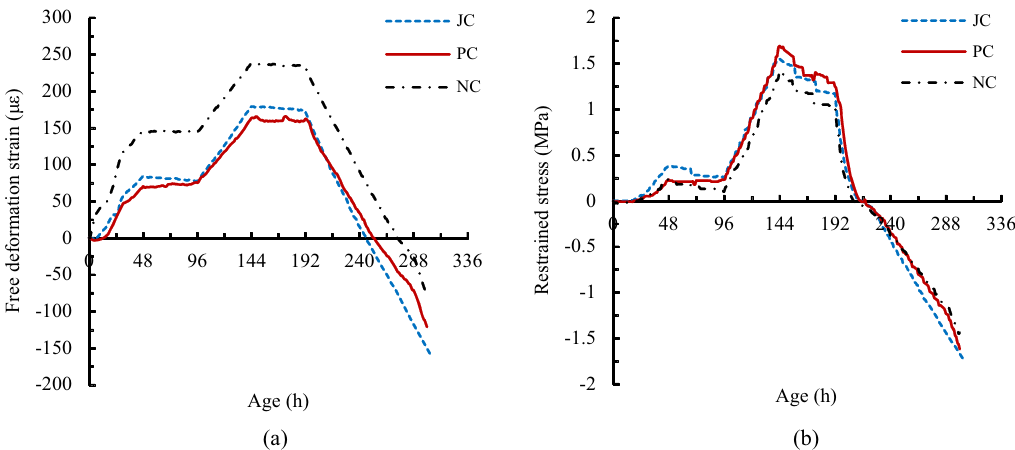
Figure 4: Measured free strain and restrained stress curves of the three concretes under TMC mode: ( a ) free deformation strain and ( b ) restrained